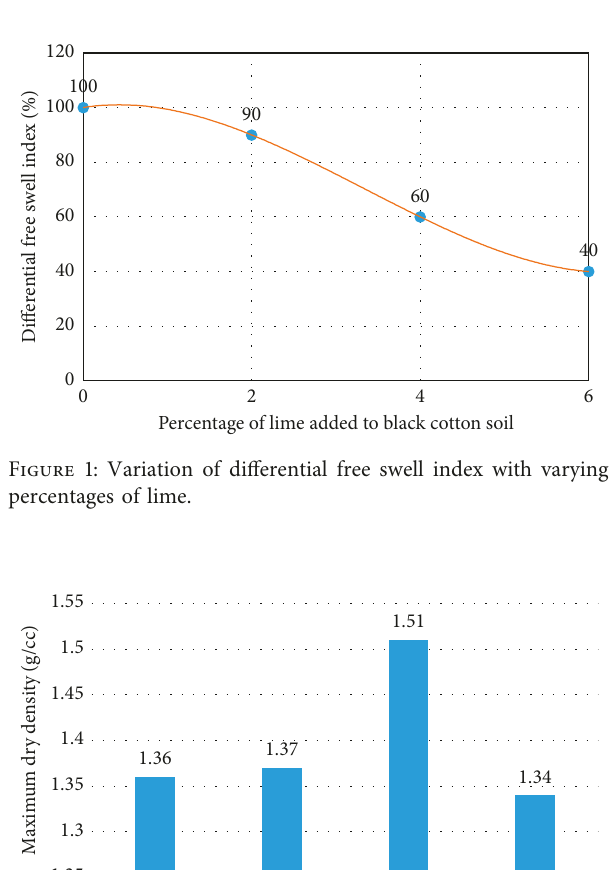
Figure 4: Variation of soaked CBR with varying contents of